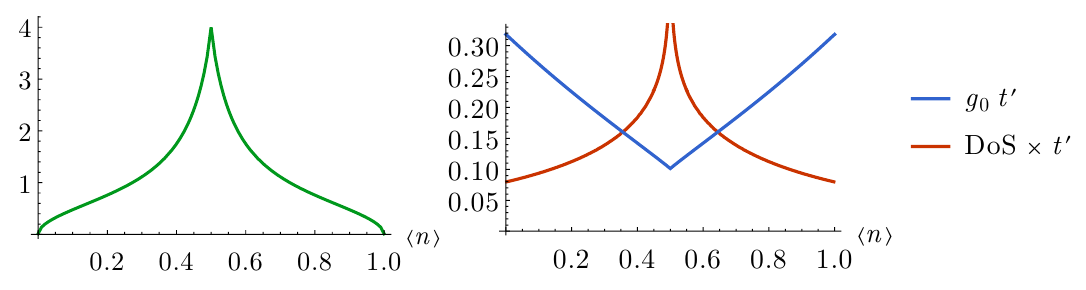
Figure 3: The BCS gap equation parameters ω (left in green) and g (right in blue) 0 from Eq. (8), and the density of states at the Fermi surface (right in red). The parameters are rescaled by t (cid:48) to make them unitless. The density of states is defined (cid:82) δ ( (cid:34) ) , where we absorbed the chemical potential µ , which depends by DoS = k k [ Eq. (18) ] . The density of states has a log on 〈 n 〉 , into the electron dispersion (cid:34) k | divergence at 〈 n 〉 = 1 / 2 where DoS ∼ 0.05 − 0.06log |〈 n 〉 − 1 2